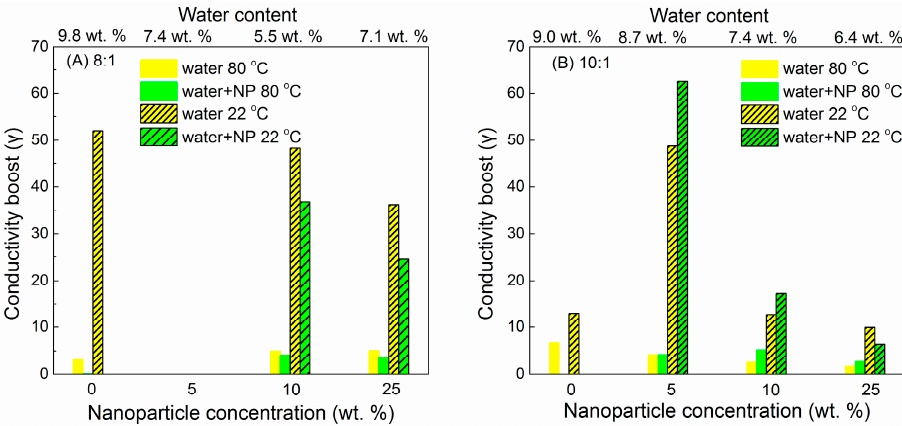
Figure 22. Conductivity boosts (“water boost”: γ water and “water+NP boost”: γ wate+NP ) at 80 and 22 °C at lithium concentrations of ( A ) 8:1 and ( B ) 10:1. The water fractions (wt %) above each nanoparticle concentration are the data for 22 °C. Data from Fullerton-Shirey et al. [185].